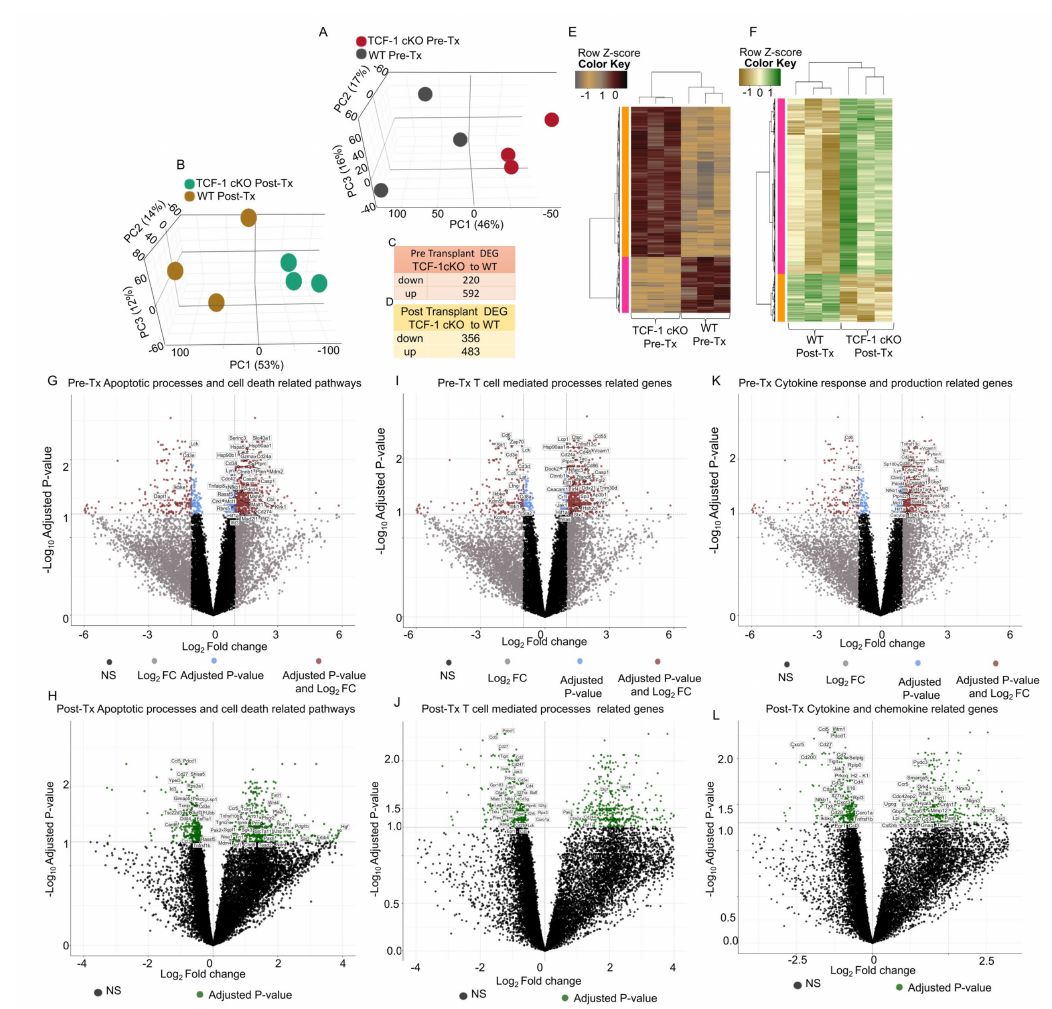
Figure 8. TCF-1 regulates key signaling pathways in donor CD4 T cells. Recipient BALB/c